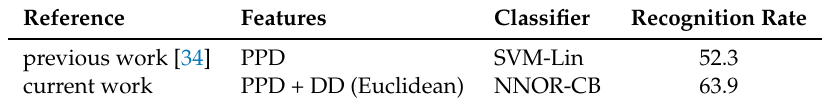
Table 5. Comparison of leave-one-subject-out, 5-fold cross-validation test results obtained for Dataset